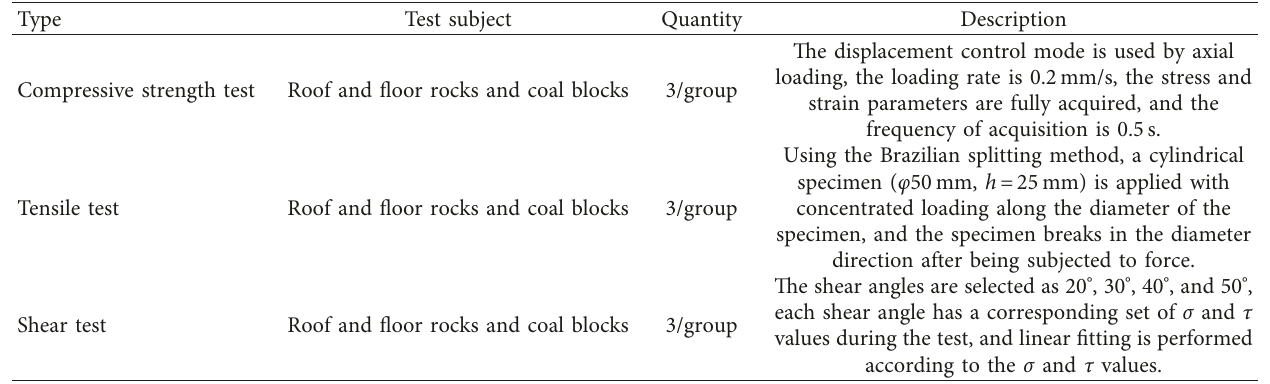
Figure 4: Test design and equipment. Table 1: Design of the mechanical property